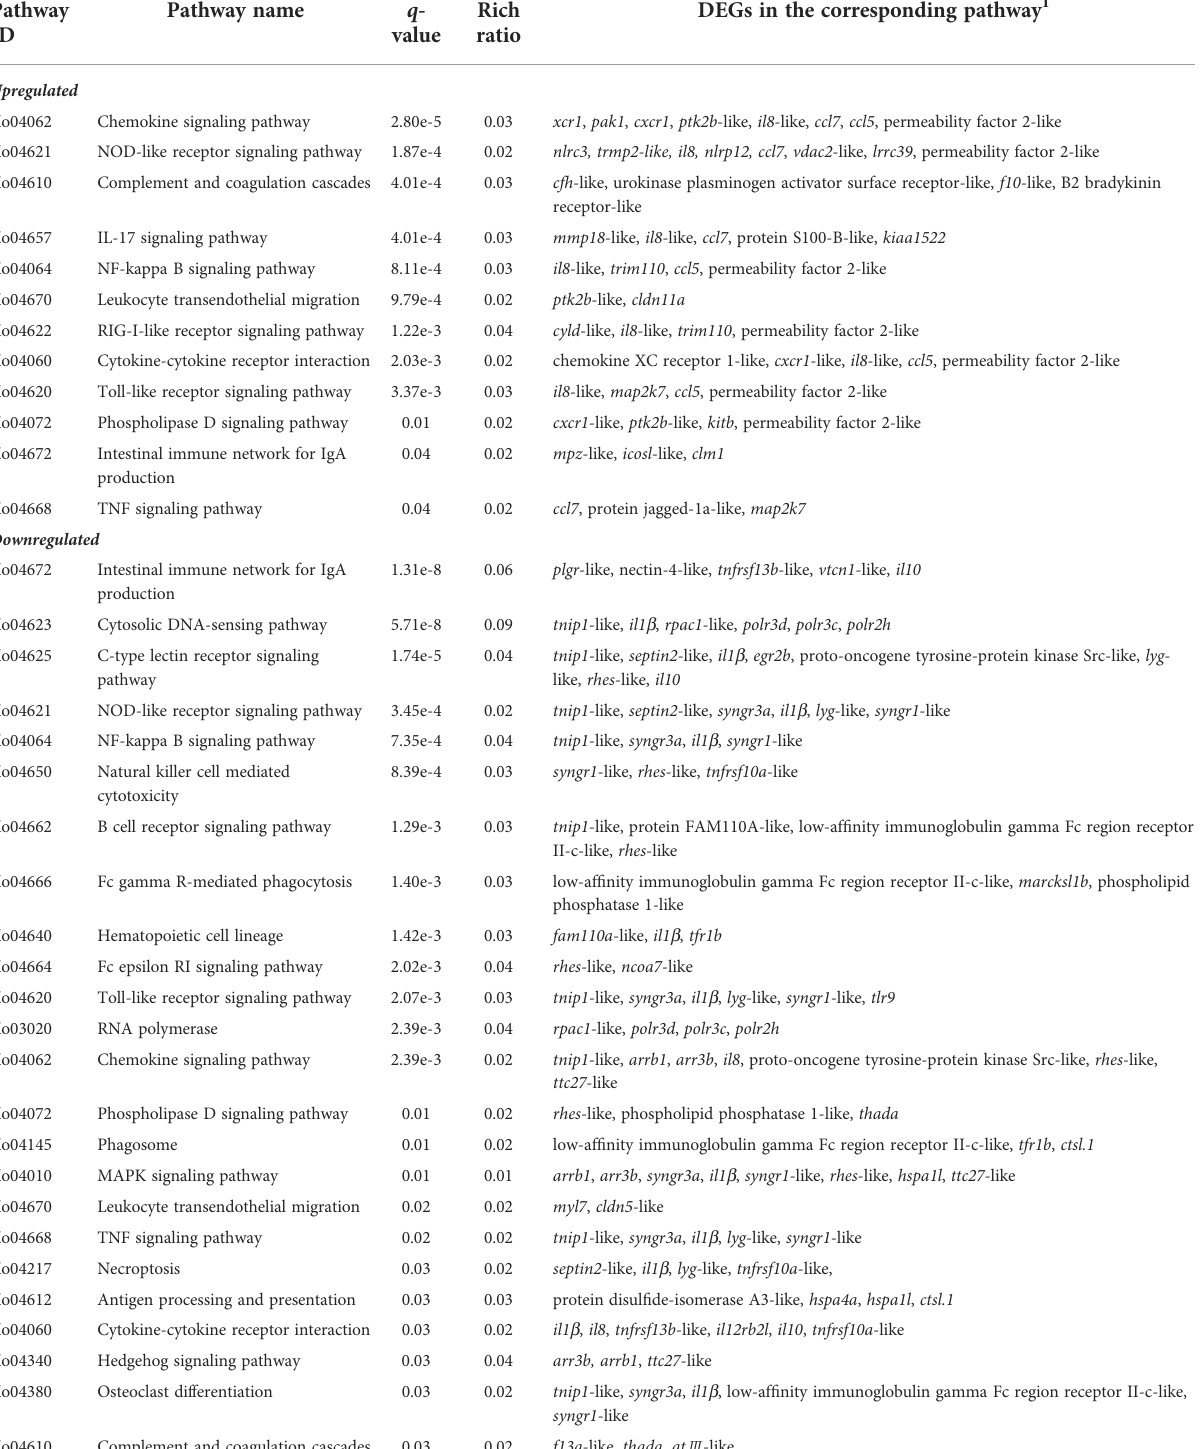
TABLE 5 The signi fi cantly enriched immune-related pathways and corresponding DEGs in the liver transcriptome of largemouth bass ( q -value <0.05).